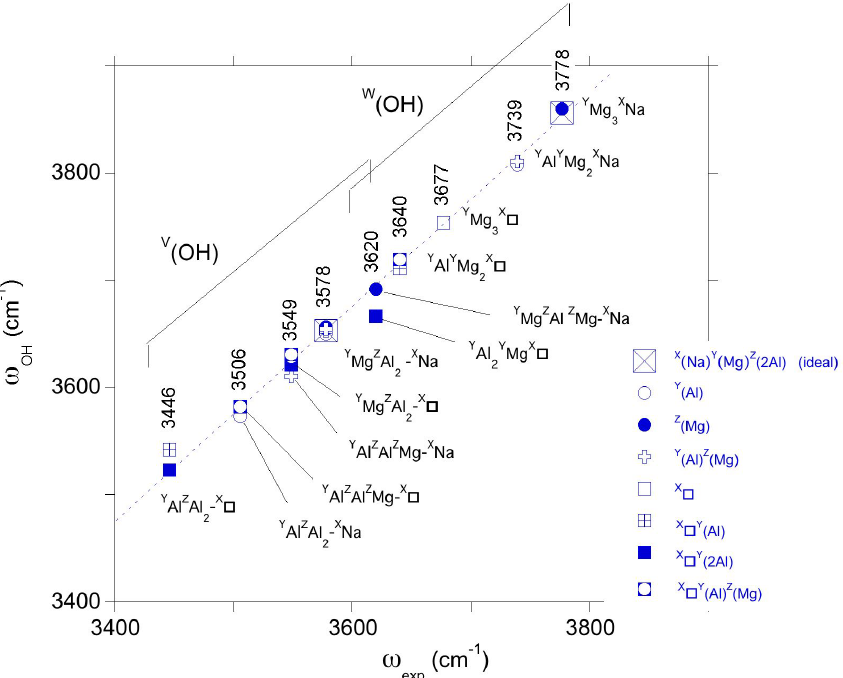
Figure 5. Relation between theoretical ( ω OH , Table 1) and experimental ( ω exp ) OH stretching frequencies in dravite. The theoretical fre- quencies are those of the larger 1 × 1 × 2 supercell models. Experimental frequencies are indicated (sample EB28 of Berryman et al., 2016, except the 3677cm − 1 frequency from Gourdant and Robert, 1997). The dotted line corresponds to the equation ω OH = ω exp + 75cm − 1